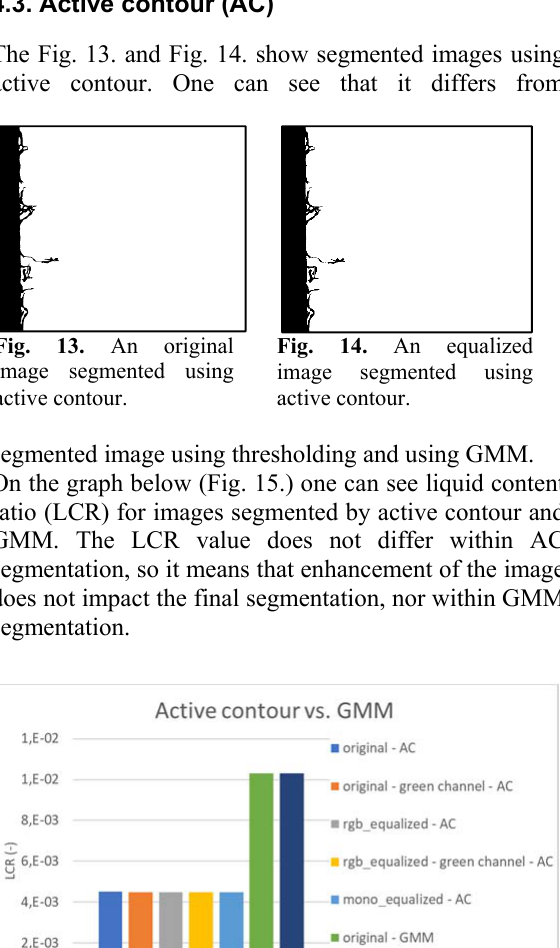
Fig. 18. An equalized image segmented using GMM.